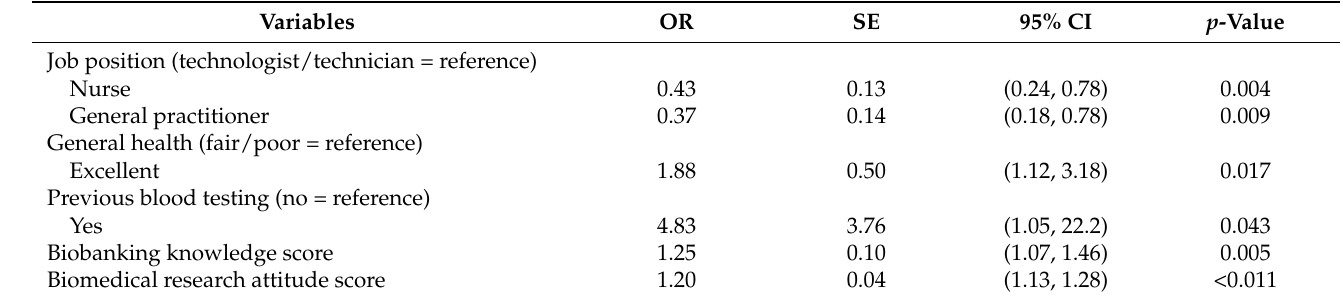
Table 5. Logistic regression model of the significant predictors of willingness to donate biospecimens.